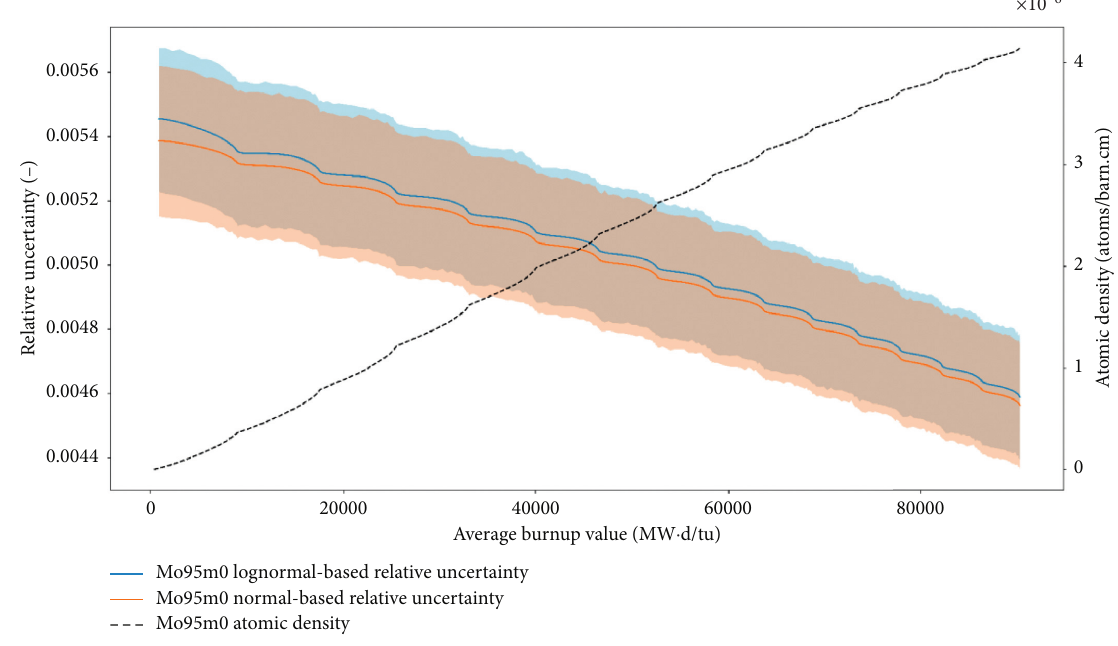
Figure 20: Relative uncertainties of Mo95m0 against fuels average burnup values. Lognormal-based sampling results (blue line) and normal-based sampling results (orange line) are plotted. The shades in this figure are the 95% confidence interval of relative